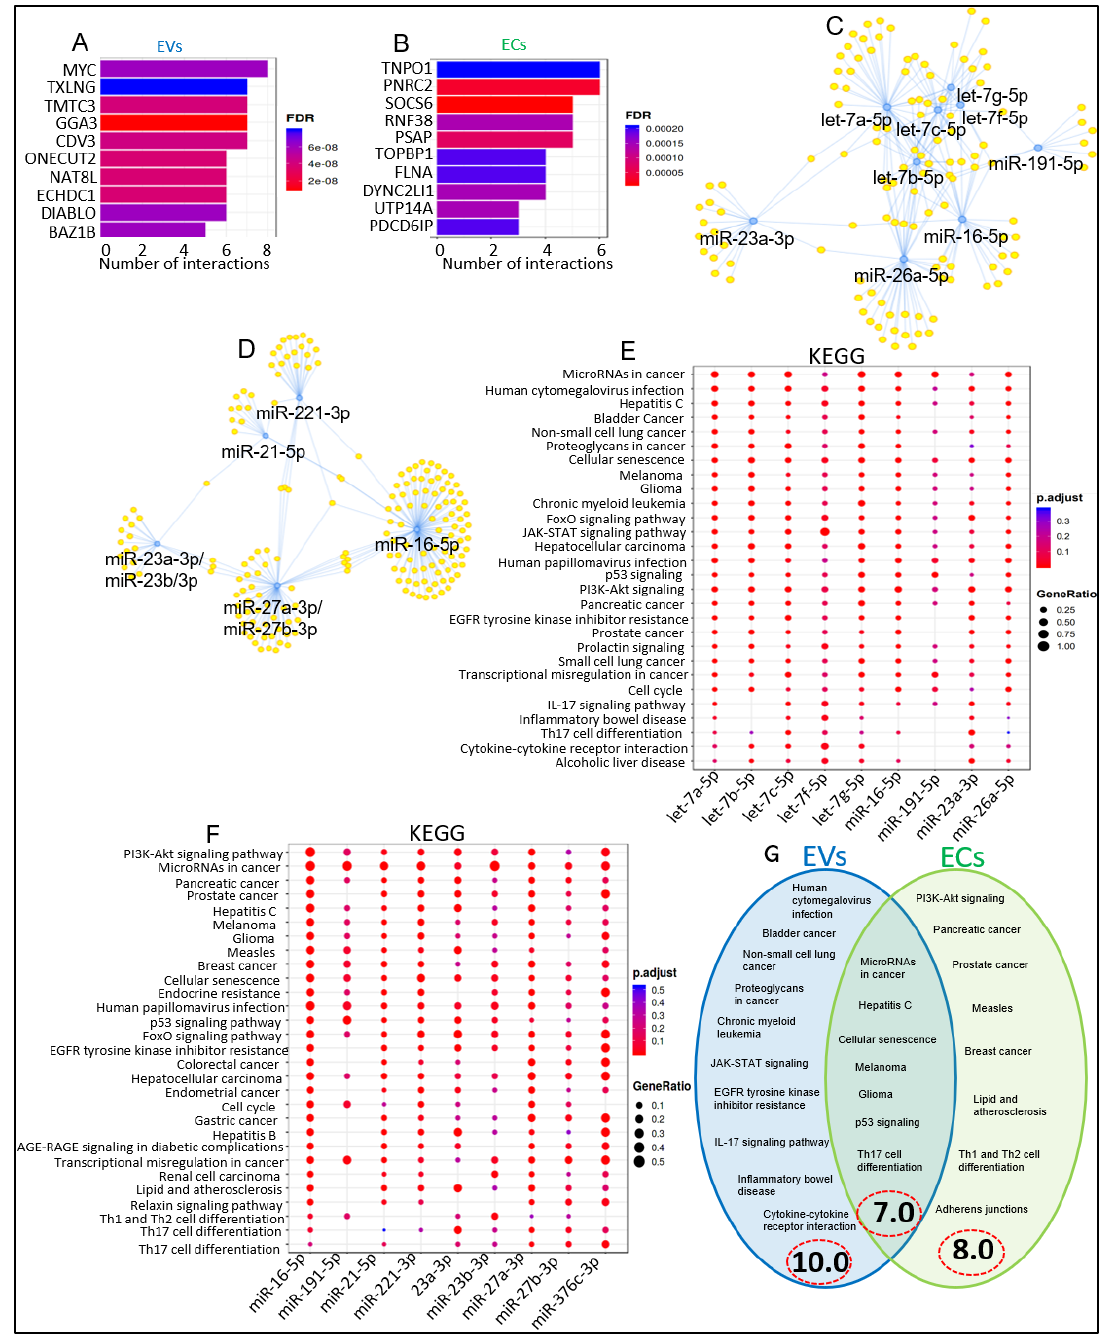
Figure 3. The top 10 miRNAs identified in EVs and ECs regulate distinctive pathways. ( A , B ) miRNA-target enrichment analysis showing top target genes by number of interactions for A) EV-associated miRNAs and ( B ) EC-associated miRNAs. The color of the bars represents adjusted p -values (FDR). ( C , D ) Visualization of miRNA-target interaction network for ( C ) EV-associated miRNAs and ( D ) EC-associated miRNAs. Blue circles indicate miRNAs, yellow circles indicate their target genes. ( E , F ) Dot plot of functional enrichment analysis for target genes of top 10 miRNAs resulting from miRNA-target enrichment analysis for ( E ) EV-associated miRNAs and ( F ) EC-associated miRNAs. Color of dots represents adjusted p -values (FDR), and size of dots represents gene ratio (number of miRNA targets found enriched in each category/number of total genes associated with that category). ( G ) Venn diagram comparing differences and similarities in KEGG pathways of EV- and EC-associated miRNAs.